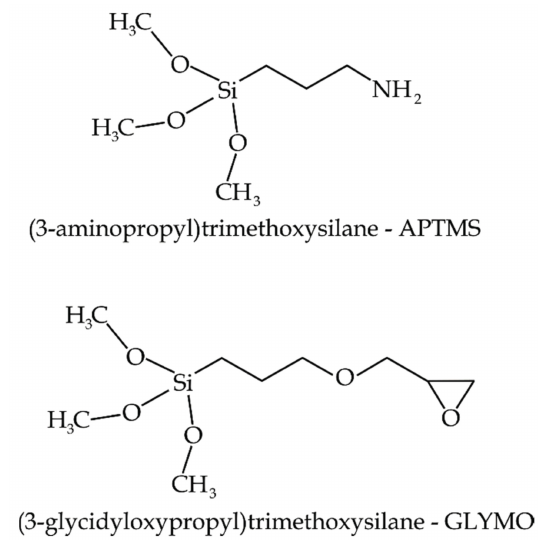
Figure 1. Image of “ Posidonia oceanica ” balls collected from the Mediterranean seashore.